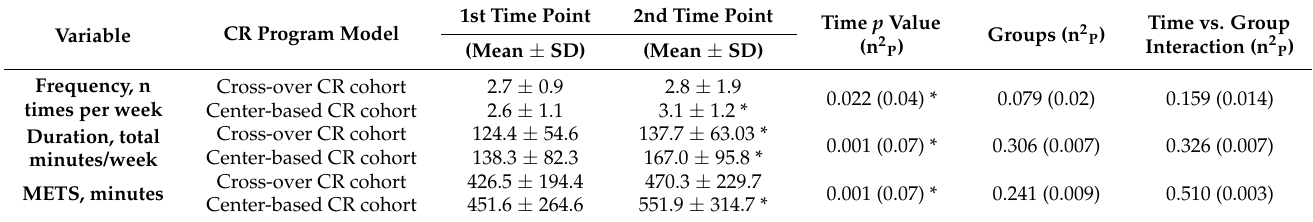
Table 2. Comparison of physical activity patterns of individuals who attended a center-based CR program (CBCR, n = 75) and those who transitioned from a center-based to a virtual CR model (cross-over CR, n = 75) during the COVID-19